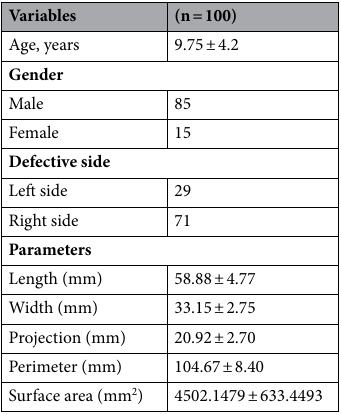
Table 1. Data summary table.